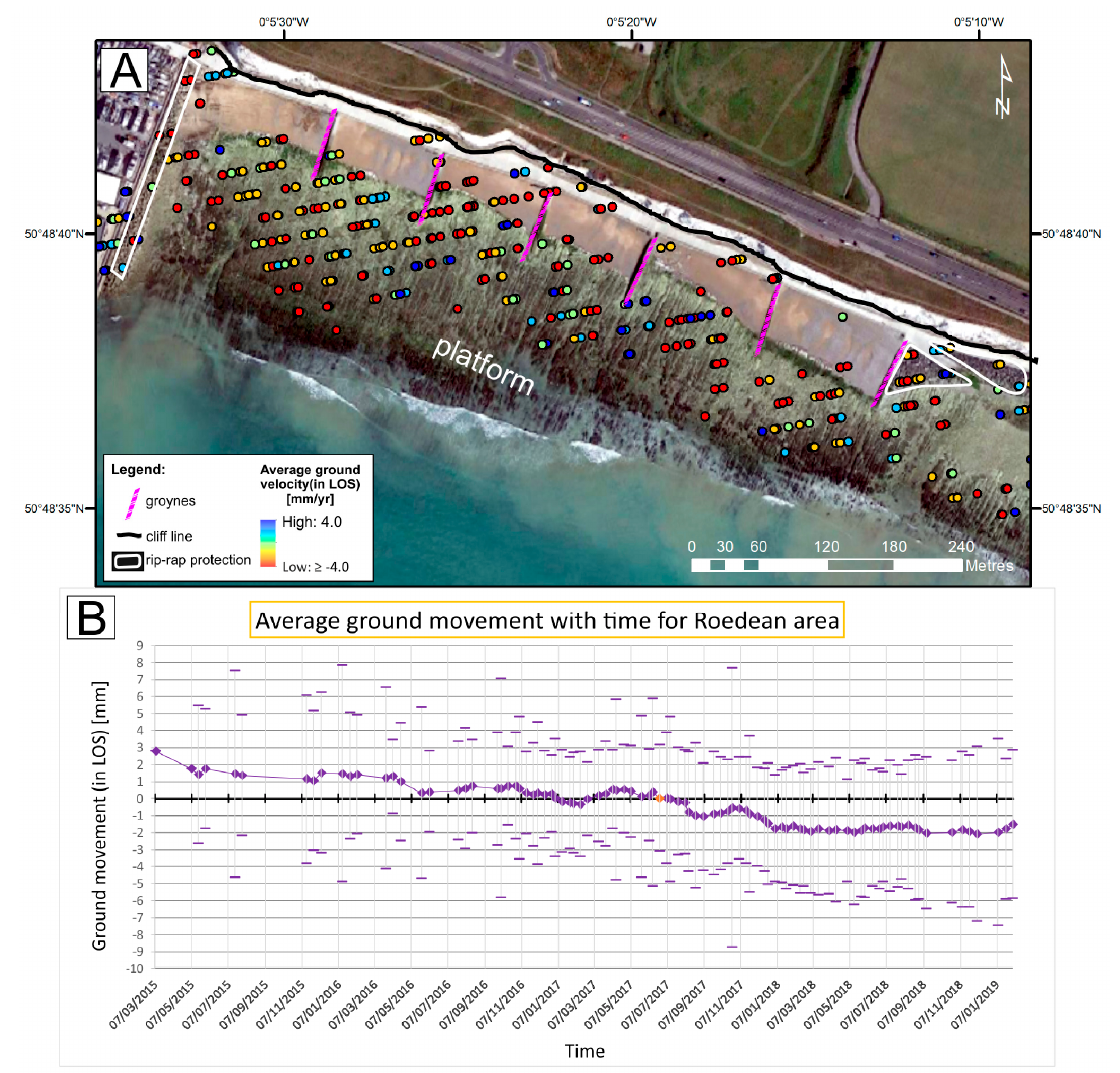
Figure 10. ( A ) Aerial view results for the Roedean research site, showing platform-engineered protection (seawall, splash wall, groynes and rip-rap) and the cliff line in the top image. The average velocity of the PS points is displayed on the ground in mm a − 1 , coloured to show the general direction of the movement: red colours represent movement away from the satellite (downward), and blue colours mean movement towards the satellite (upwards). The bottom image ( B ) shows the average ground movement with the time for the whole area, the vertical axis displaying the ground movement in mm, and the horizontal axis showing the time (from March 2015 until January 2019). Error bars on the plot show the standard deviation calculated for the data, presented to visualise the variability. Top image created in ArcGIS with georeferenced Google Earth Image (04/01/2019).